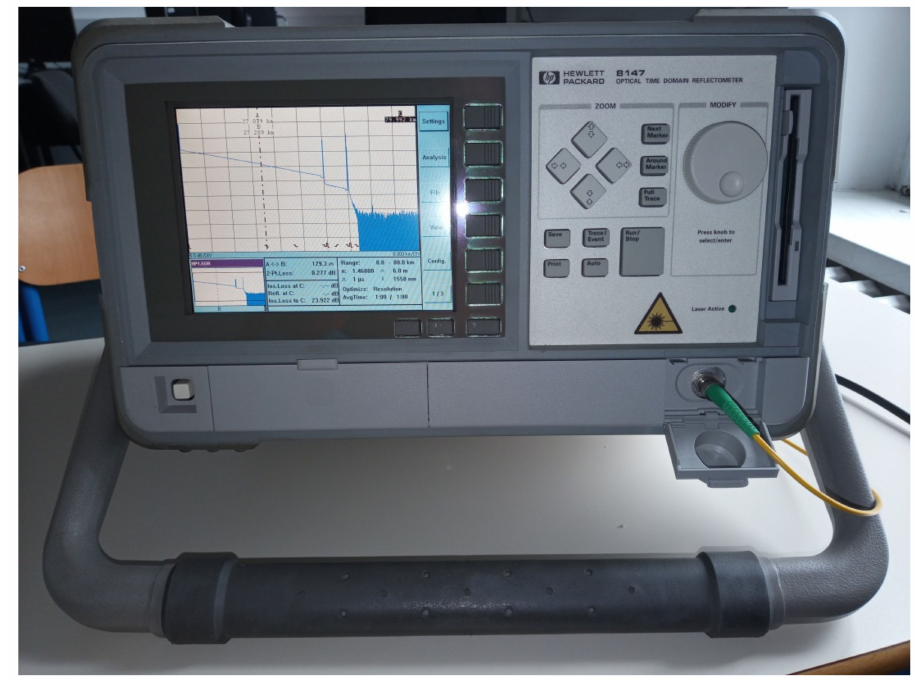
Figure 7. OTDR under